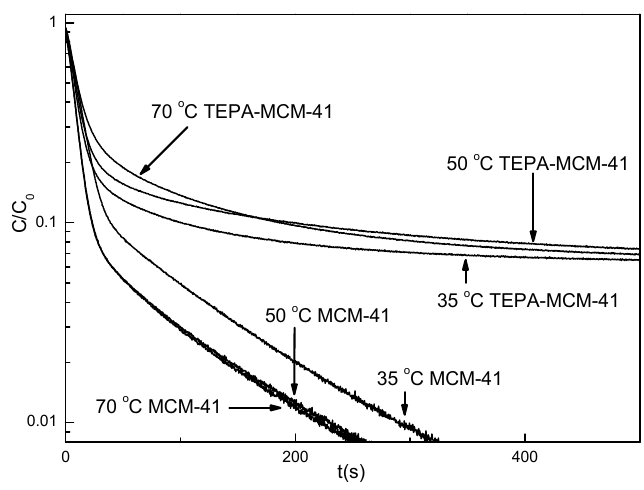
Figure 1. Desorption curves of MCM-41 and MCM-41-TEPA.